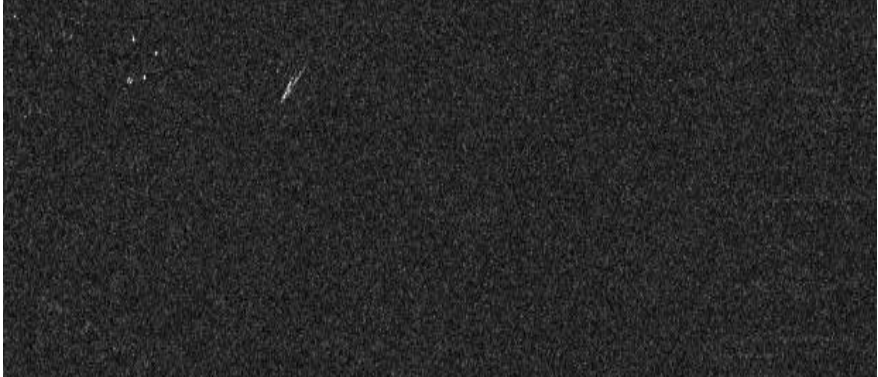
Figure 7. SAR image before interference suppression.